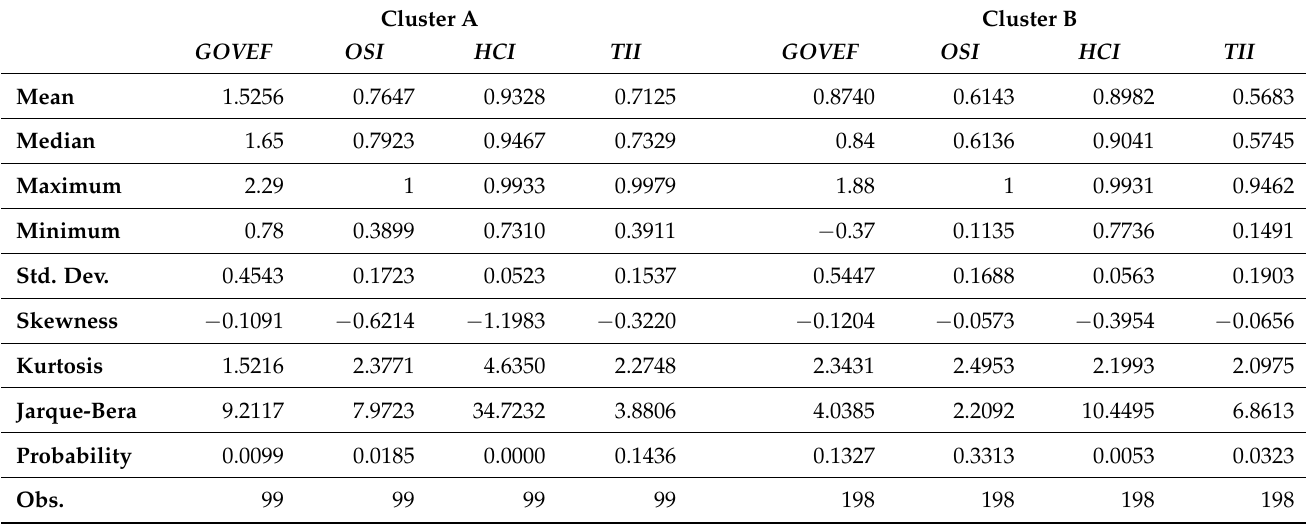
Table 3. Descriptive statistics of the variables.